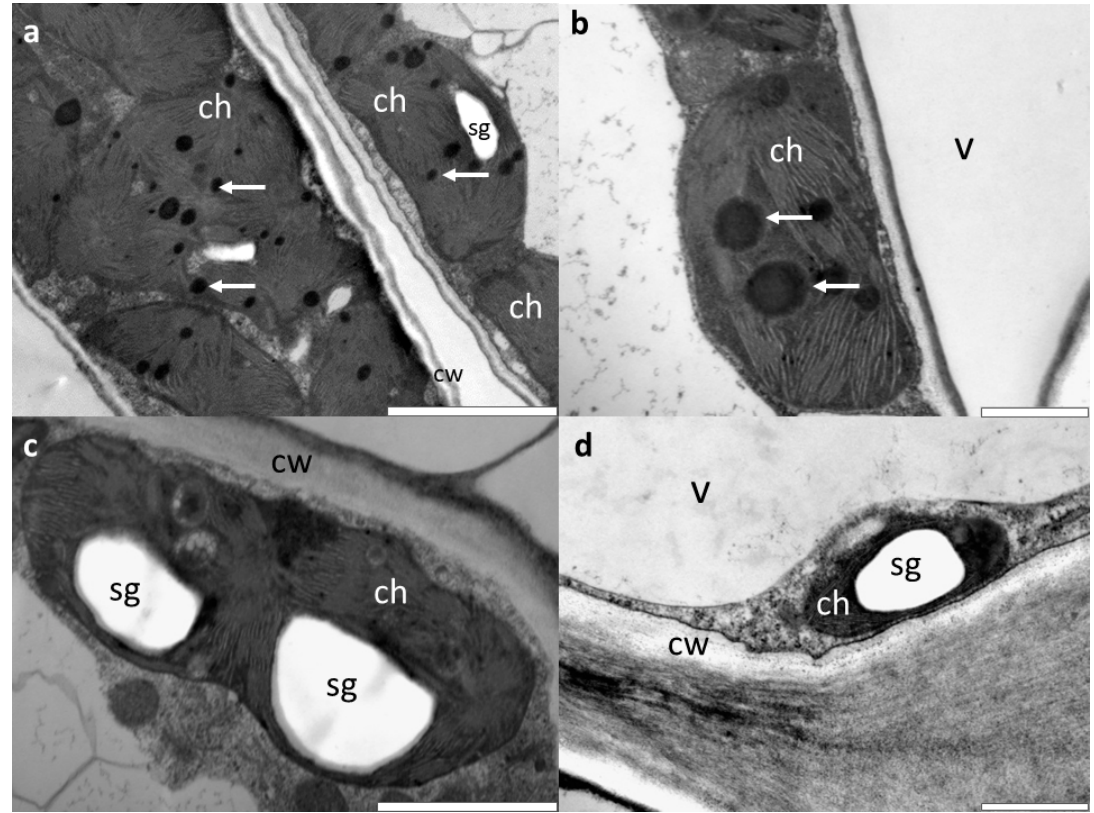
Figure 2. Ultrastructure of oak leaves under TEM. ( a ) Cross-section of palisade mesophyll cells in control oak leaf. ( b ) Plant treated with 50 ppm CuNPs—chloroplast with disturbed ultrastructure, large plastoglobules. ( c , d ) Chloroplasts from plants treated with 50 ppm AgNPs containing large